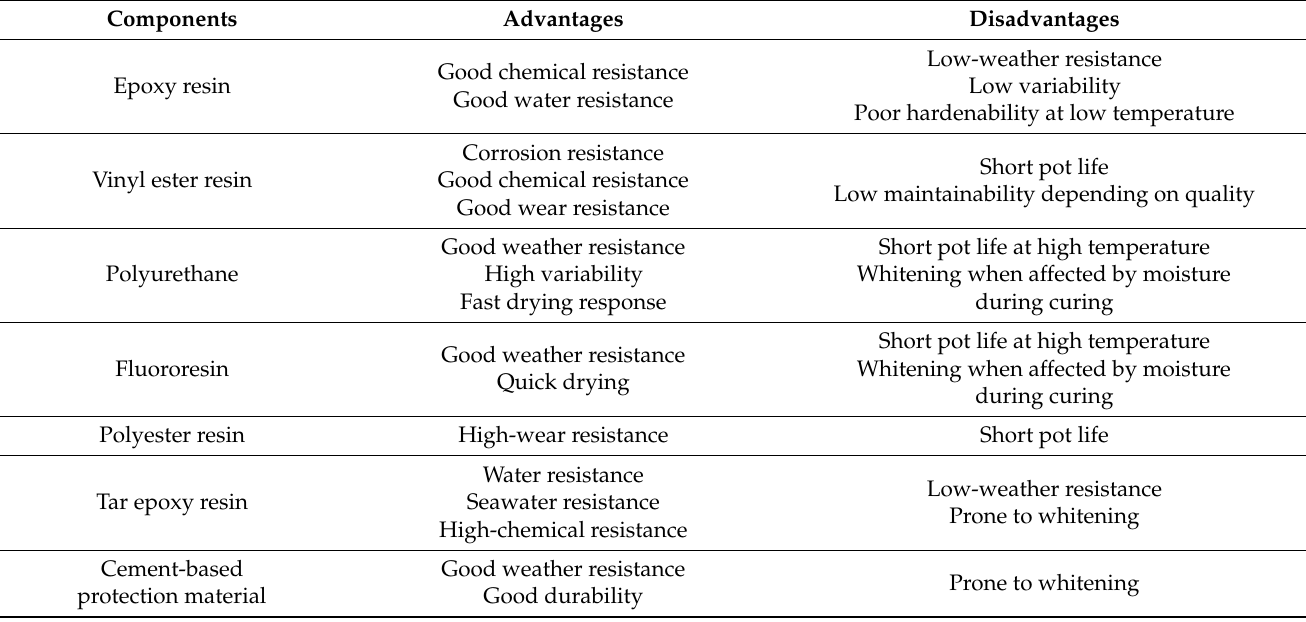
Table 1. Advantages and disadvantages of structure protection